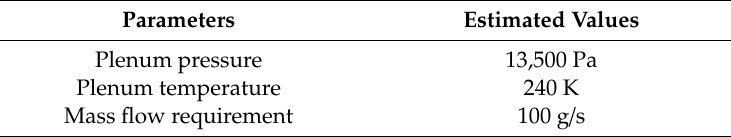
Figure 14. Plenum Segment used for case study. Table 1. Design point parameters for the plenum segment.